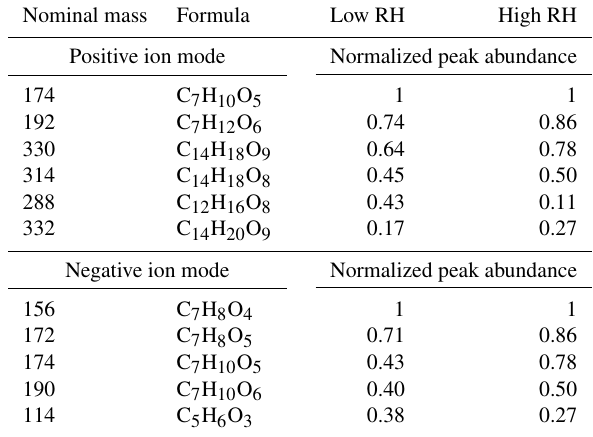
Table 1. The five most abundant compounds observed in the low- and high-RH low-NO x toluene SOA samples. In positive ion mode, the most abundant species differed by one compound in the low- and high-RH experiments, and hence the table contains six formu- las. In negative ion mode, the same five most abundant peaks were observed at the low and high